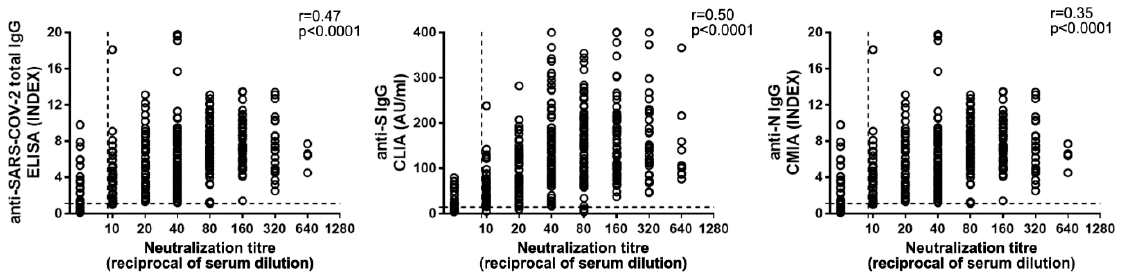
Figure 4. Anti-SARS-CoV2 IgG correlation to NAb titers. Total anti-SARS-CoV-2 (left panel), anti-Spike (anti-S) (central panel), and anti-Nucleoprotein (anti-N) (right panel) IgG levels were compared to NAb titers. Horizontal dot line indicates limit of NAb level quantification, vertical dot line indicates the limit of IgG detection. Spearman’s test was used for correlation analysis.